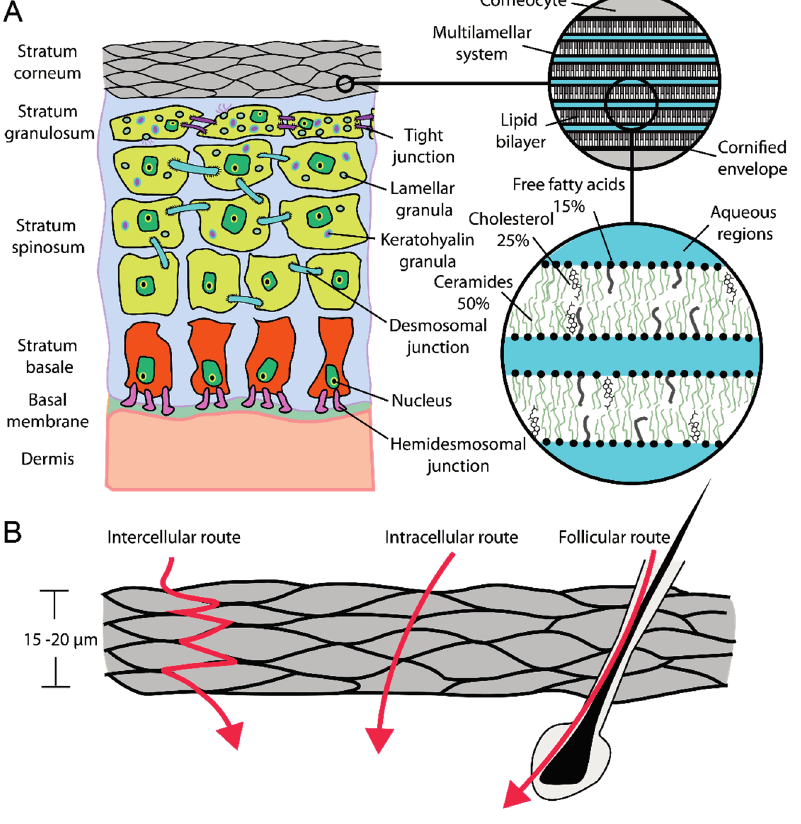
Figure 1. ( A ) Schematic of skin; ( B ) Dermal penetration